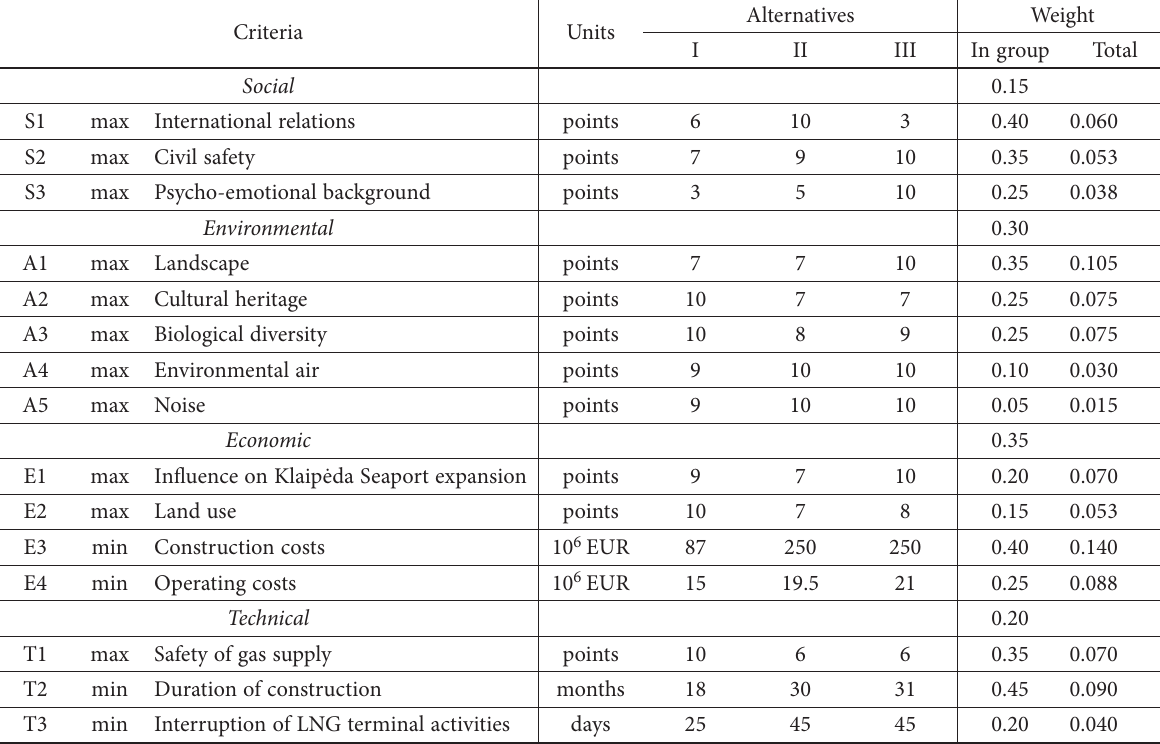
Table 1. The main matrix of natural gas terminal combined data